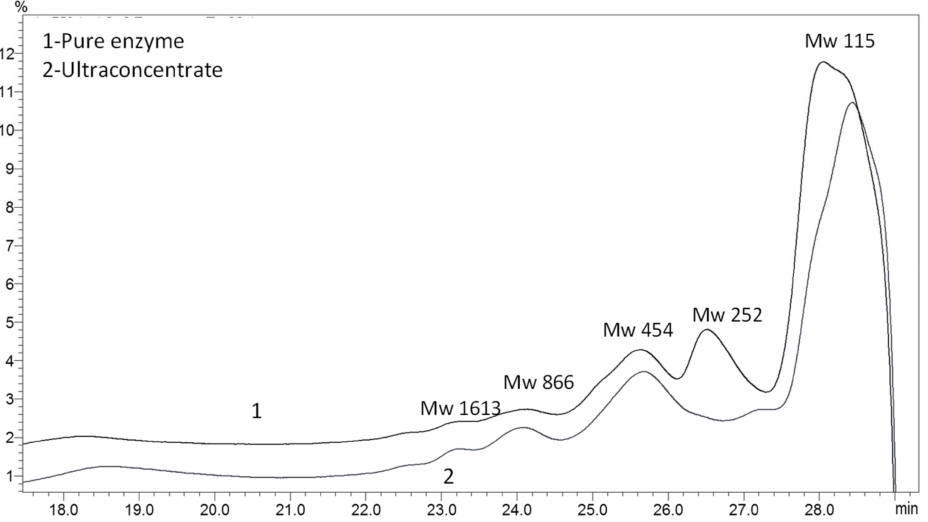
Figure 5. GPC elution pattern of PCL degradation intermediates after a week of cultivation of B. thermoruber strain 7. (1), PE; (2),